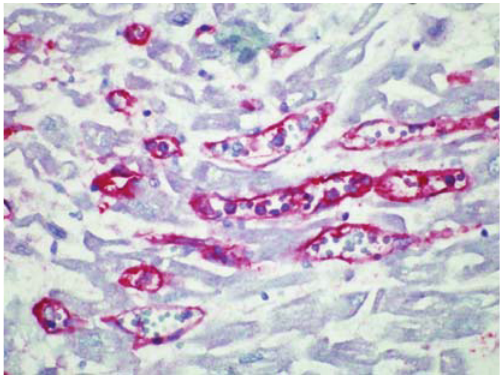
Figure 3: Antibody-mediated rejection, high power. C4d decorates endothelial cells in this immunoperoxidase-stained